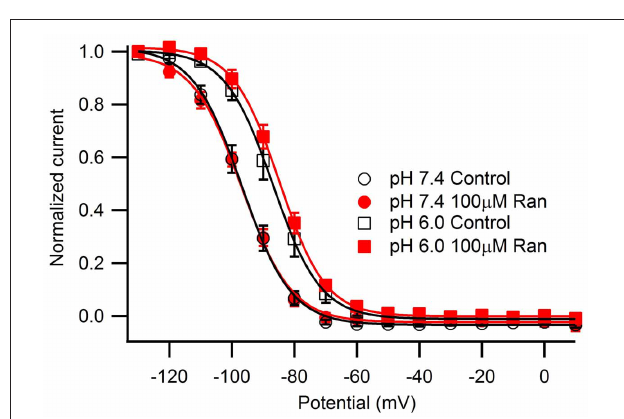
FIGURE 2 | Steady-state fast inactivation induced by 500ms conditioning pulses ranging from − 130mV to + 10mV in 10mV intervals and measured by a test pulse to − 10mV. Channels were held at − 130mV for 10s between sweeps. pH 7.4 control (open black circles) differed significantly from pH 6.0 control (open black squares). 100 μ M ranolazine had no effect on steady-state fast inactivation (pH 7.4, solid red circles; pH 6.0, solid red squares). Fit parameters are summarized in Table A3